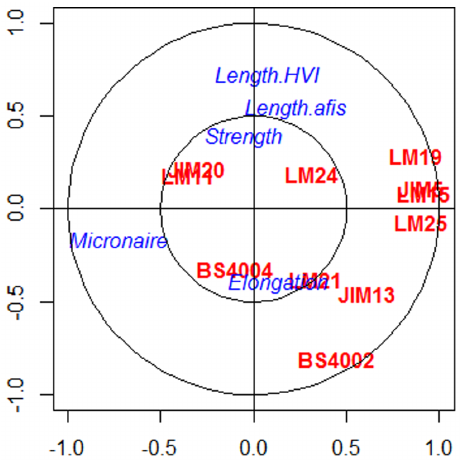
Figure 2. Graphical representation of the variables selected by sPLS on the first two dimensions predicts specific cell wall polysaccharides linked to the fiber properties. The coordinates of each variable are obtained by computing the correlation between the latent variable vectors and the original dataset. The selected variables are then projected onto correlation circles where highly correlated variables cluster together. These graphics help to identify association between the two datasets. The correlation between two variables is positive if the angle is sharp cos( a ) . 0, negative if the angle is obtuse cos( h ) , 0, and null if the vectors are perpendicular cos( b ) ,